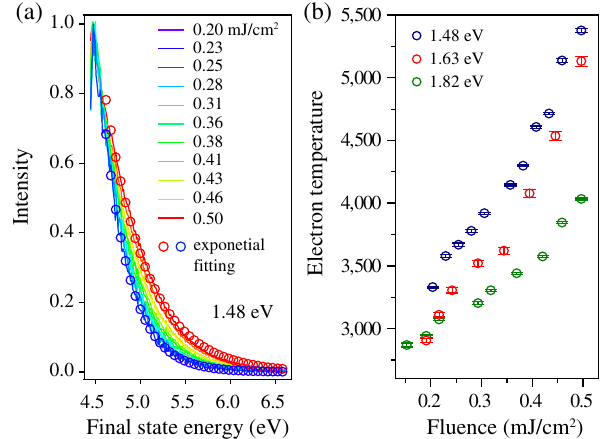
FIG. 4. (a) Exponential fitting of the normalized s -polarized mPP spectra for different laser fluences and h ν ¼ 1 . 48 eV. (b) The fluence-dependent temperatures for s -polarized mPP spectra excited with h ν ¼ 1 . 48 , 1.63, and 1.82 eV. Note that light quanta h ν with smaller energy produce hotter electron